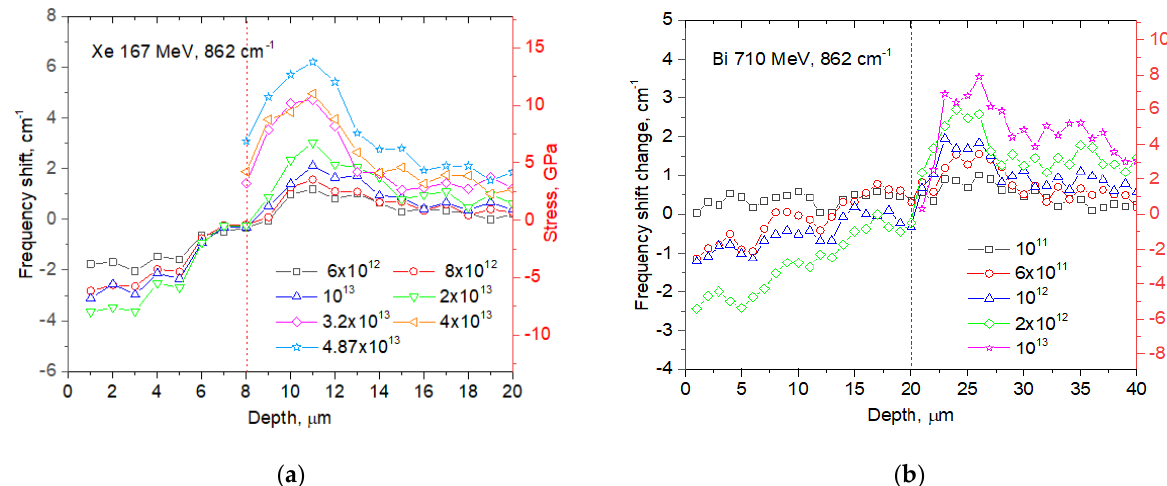
Figure 4. Variation of the spectral position of the 862 cm − 1 line over the depth of the irradiated layer for different ( a ) Xe and ( b ) Bi ion fluences.